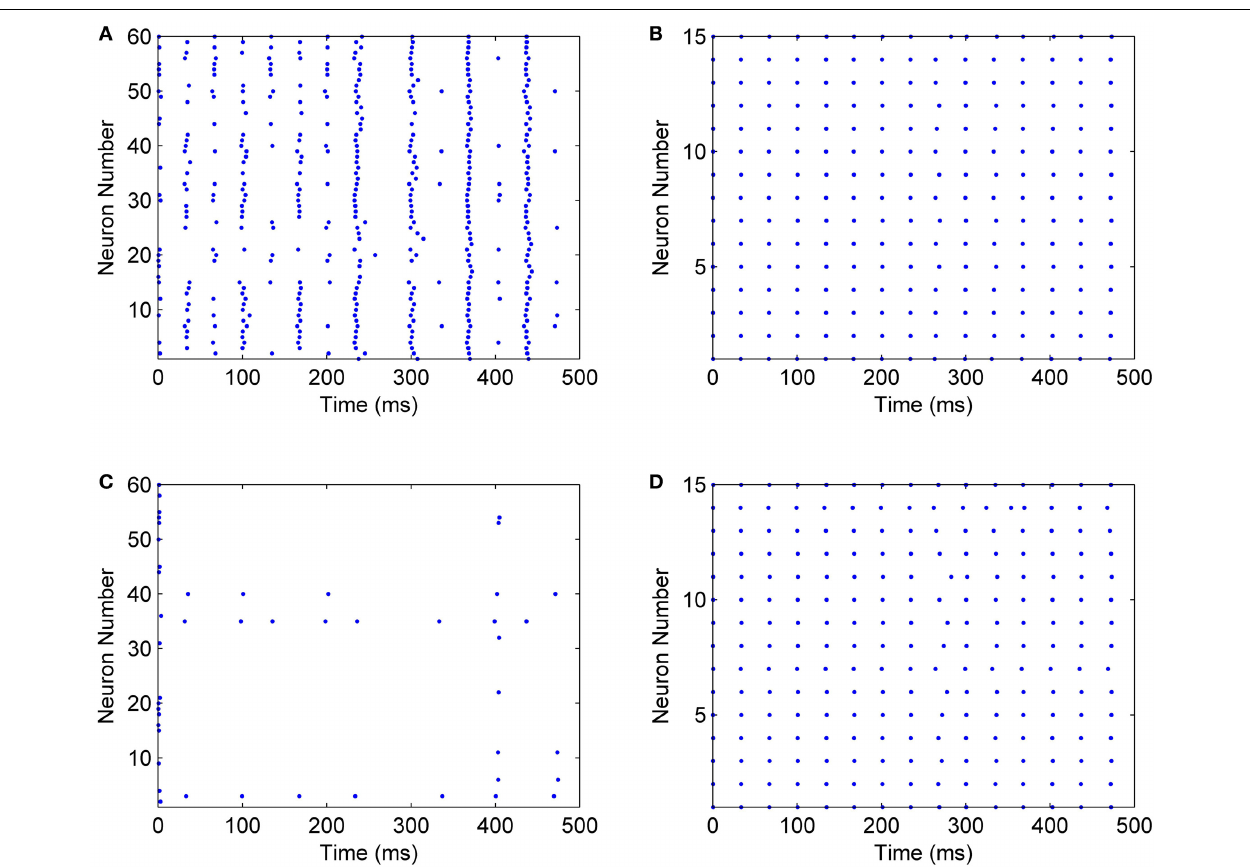
FIGURE 13 | Rastergrams of the implemented neural network, for (A) The excitatory pool in mini-column 2, (B) The inhibitory pool in mini-column 2, (C) The excitatory pool in mini-column 1, (D) The inhibitory pool in mini-column